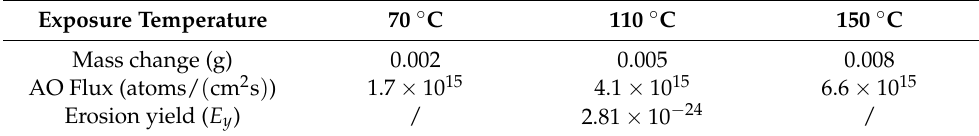
Table 1. Mass change of Kapton ® HN film and atomic oxygen (AO) flux estimation. Exposure Temperature